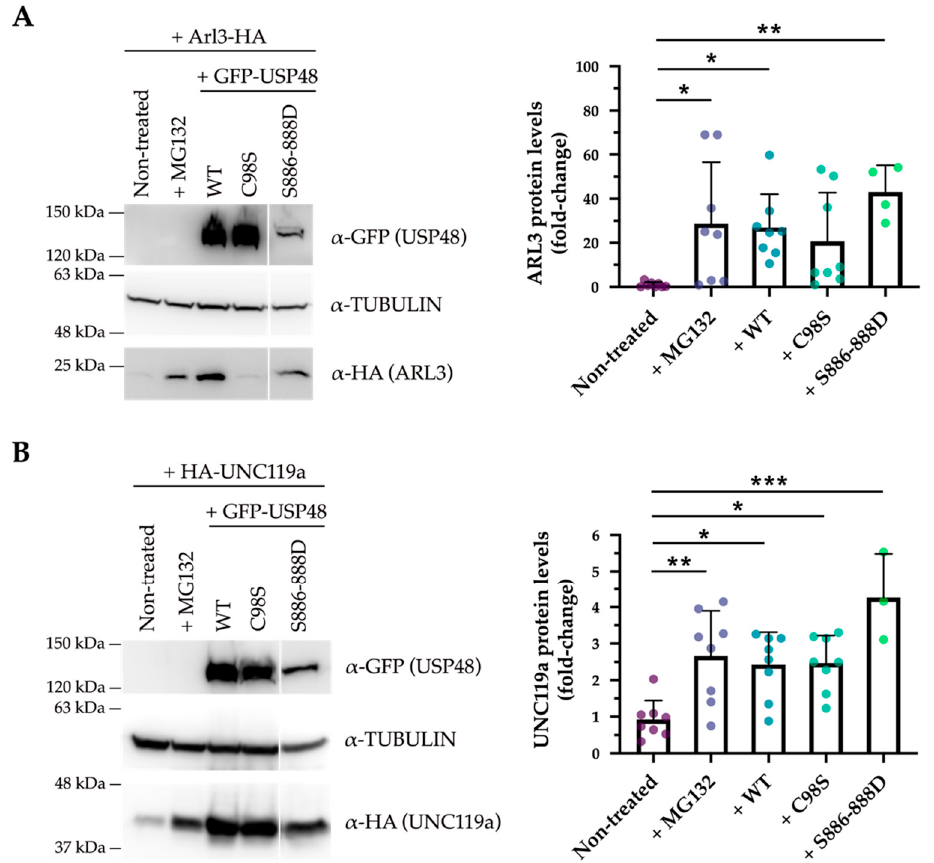
Figure 6. USP48 stabilises ARL3 and UNC119a by different mechanisms. ( A ) ARL3-HA is degraded by the proteasome (rescued by MG-132 treatment) and stabilised by USP48 in a DUB-dependent manner. Note that the hyper-active GFP-USP48 S886 − 888D mutant is able to rescue ARL3 to a higher level (Kruskal-Wallis test; * = p -value ≤ 0.05, ** = p -value ≤ 0.01; n = 4–8 independent replicates). ( B ) HA-UNC119a is also degraded by the proteasome, and the rescue by USP48 is independent of its DUB activity, since the catalytically inactive GFP-USP48 C98S mutant is also able to stabilise UNC119a (one-way ANOVA; * = p -value ≤ 0.05, ** = p -value ≤ 0.01, *** = p -value ≤ 0.001; n = 3–8 independent experiments). All data represent the mean ± SD.